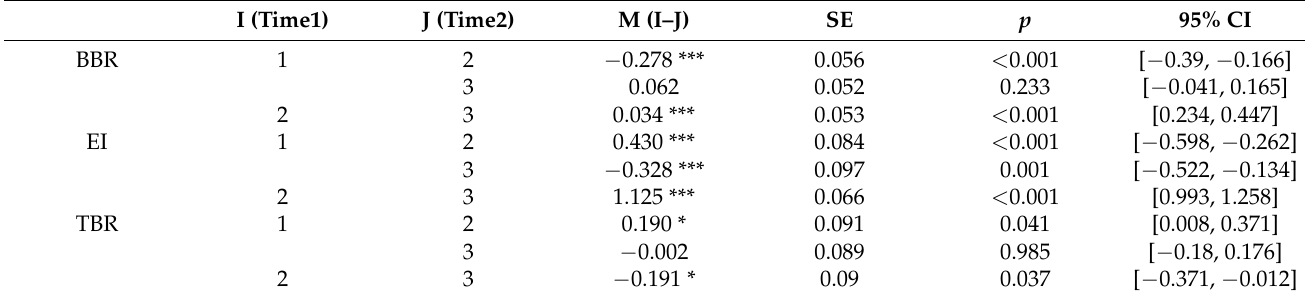
Table A9. Post-test